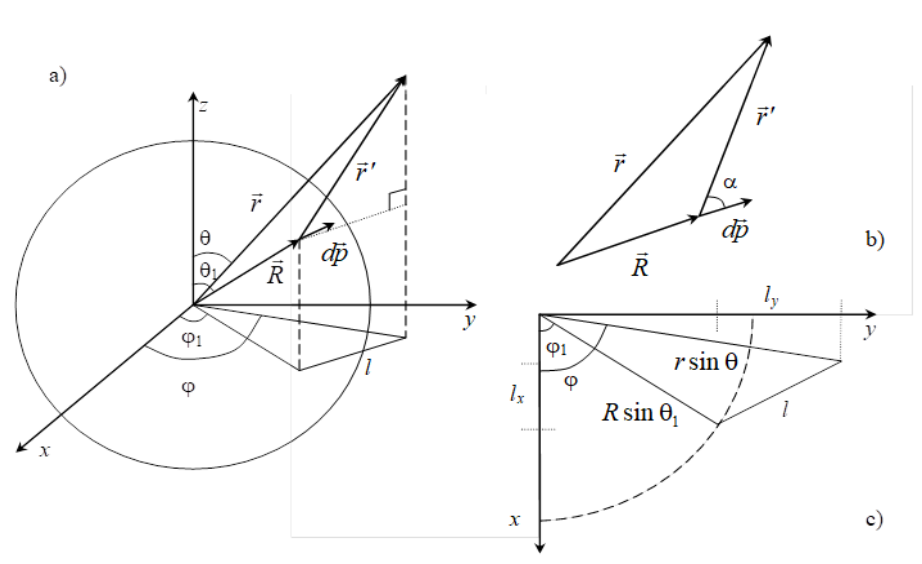
Fig. 1. Spherical thin